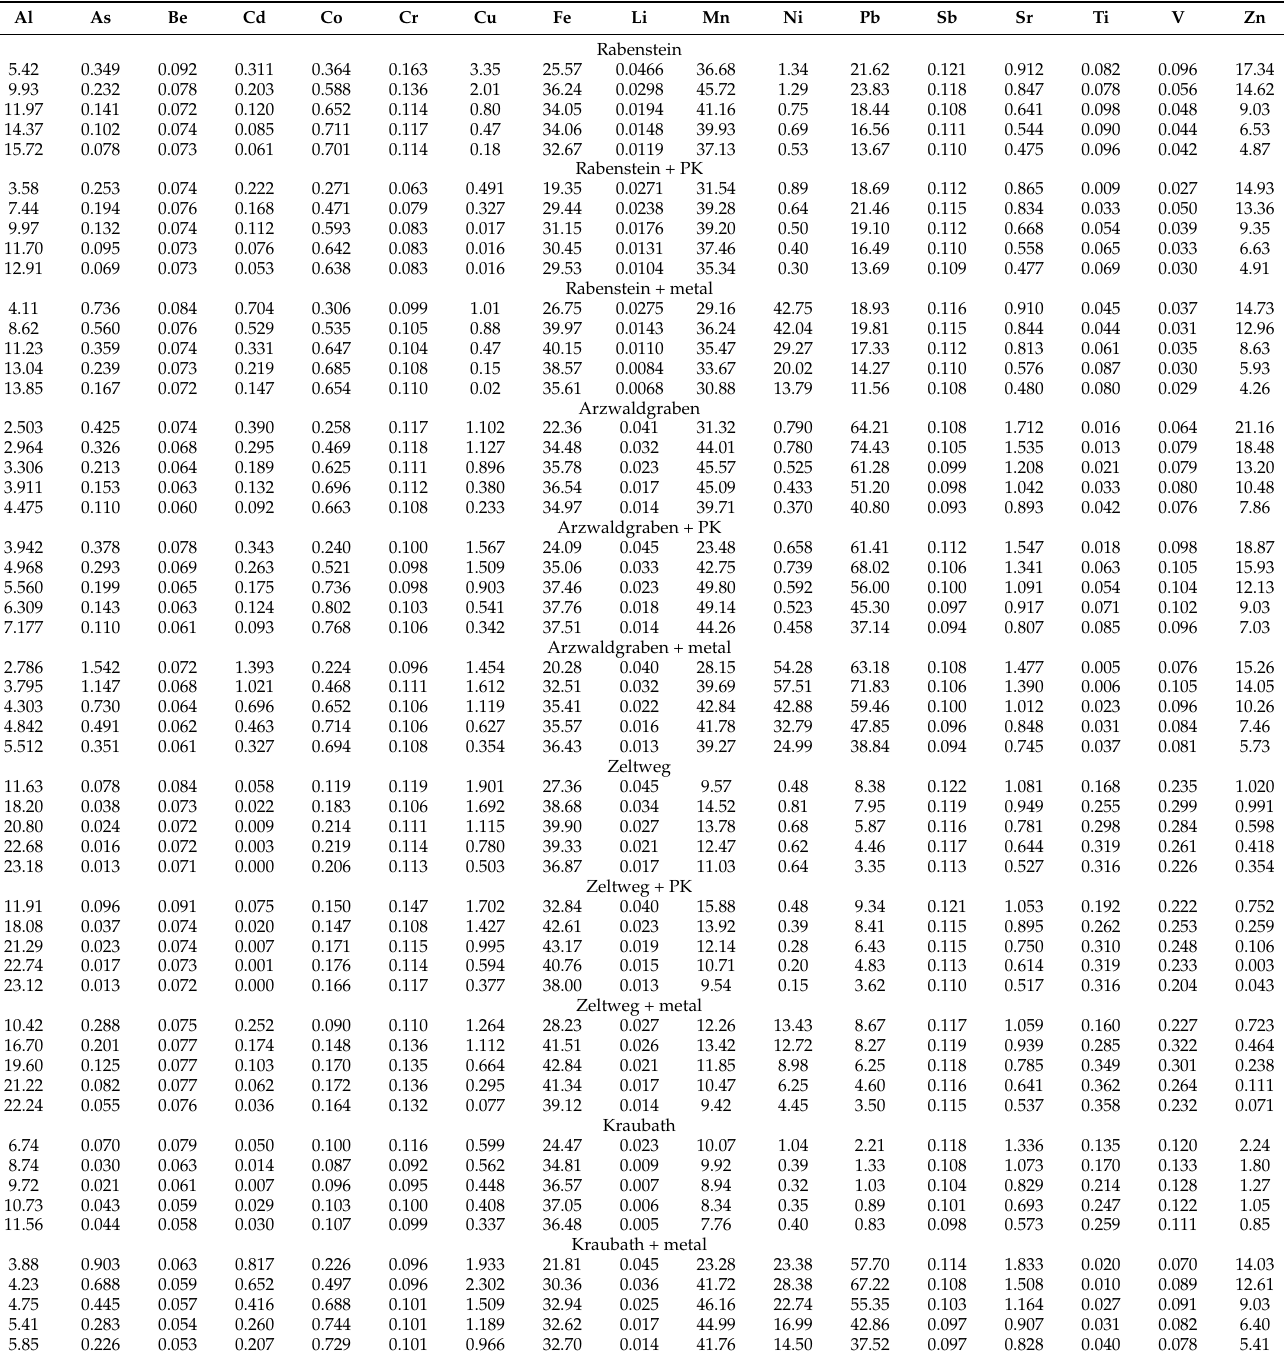
Table 3. Released amounts after 5, 10, 15, 20, and 25 min of electro-ultrafiltration in 0.002 M